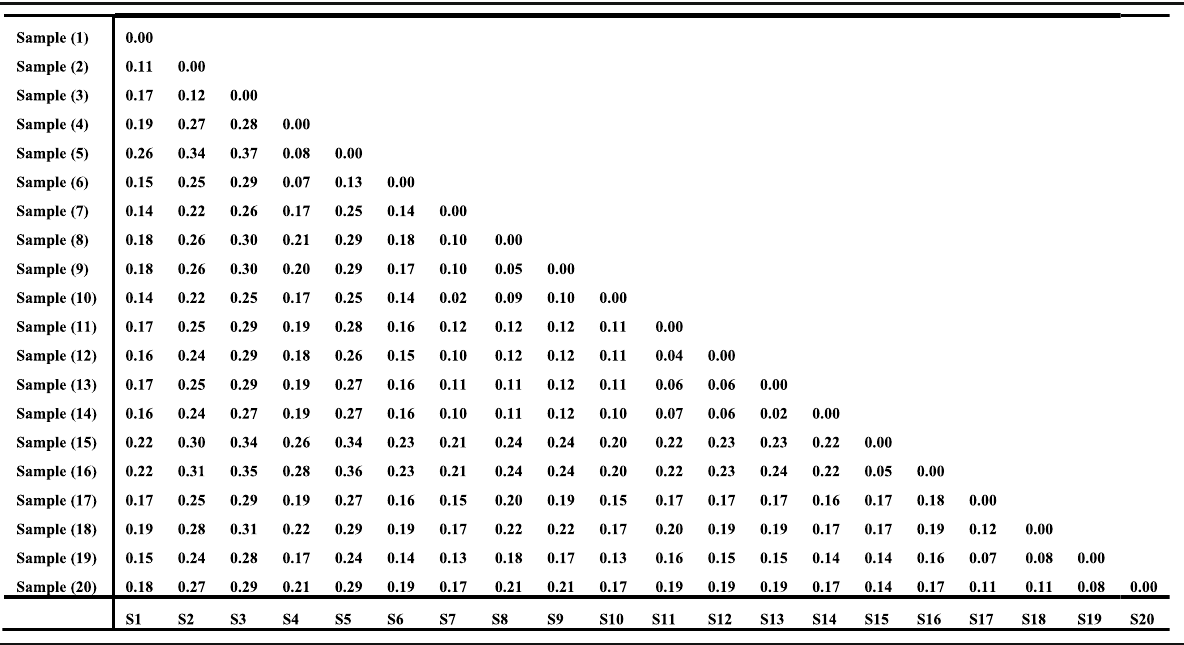
Table 3 Estimates of evolutionary divergence between sequences of 20 different Triticum